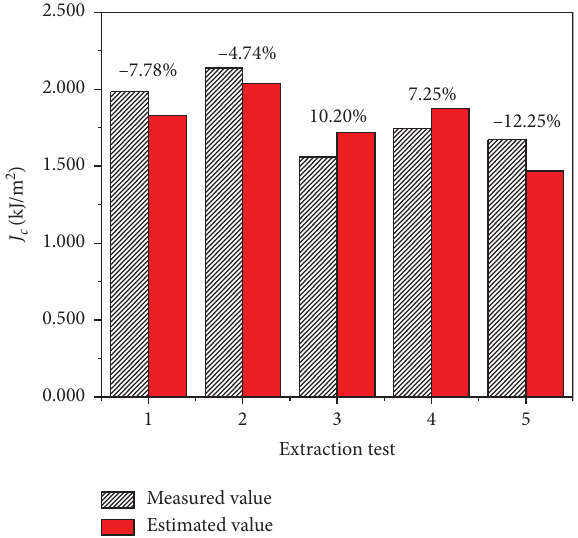
Figure 14: Comparison between the predicted and measured values of the SCB test. Table 17: Asphalt-stone ratio determined by online detection of asphalt mixture plant.